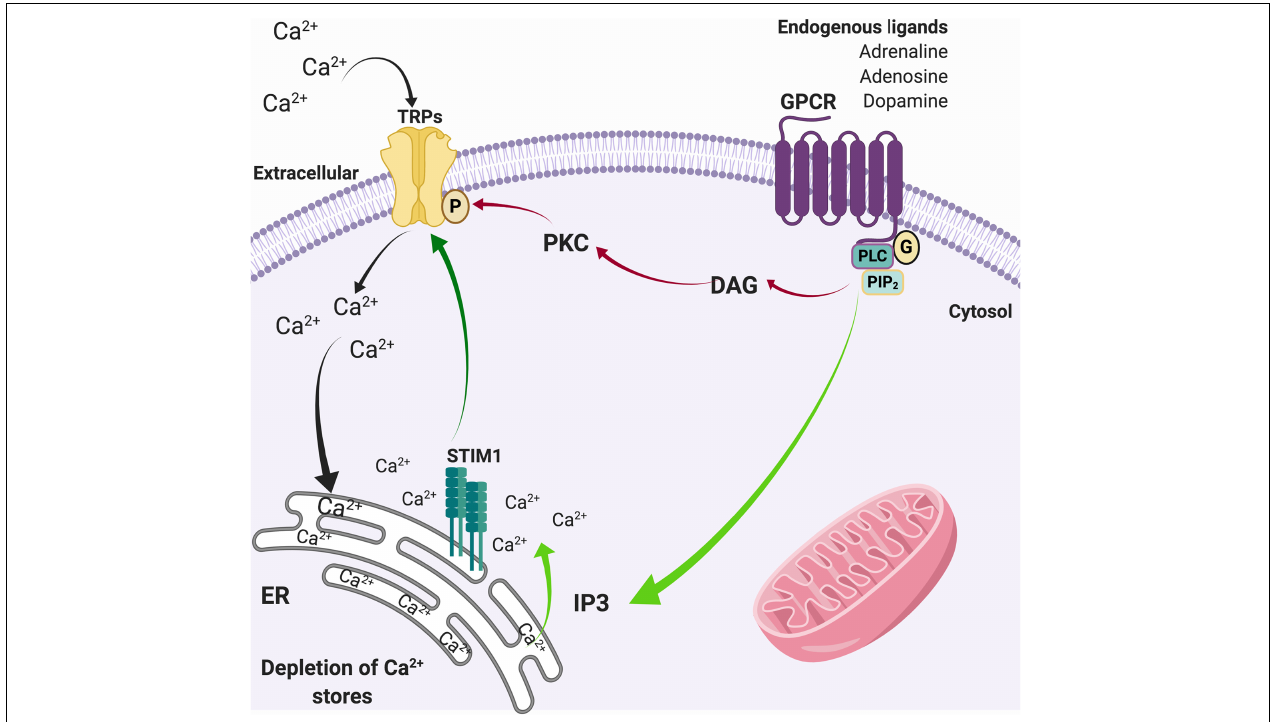
FIGURE 2 | SOCE through TRP channels. Activation of G-protein coupled receptors activates the phospholipase C pathway that induces the hydrolysis of PIP 2 to DAG (red arrows) that actives PKC, which in turn phosphorylates TRP channels. In parallel, the generation of IP 3 (green arrows) promotes the release of Ca 2 + from the ER. The depletion of intracellular Ca 2 + stores from the ER is sensed by STIM1, which also activates Ca 2 + channels in the plasma membrane such as TRPs (dark green arrow), allowing the entry of Ca 2 + from the extracellular medium to the cytosol (black arrows) to refill de ER deposits.